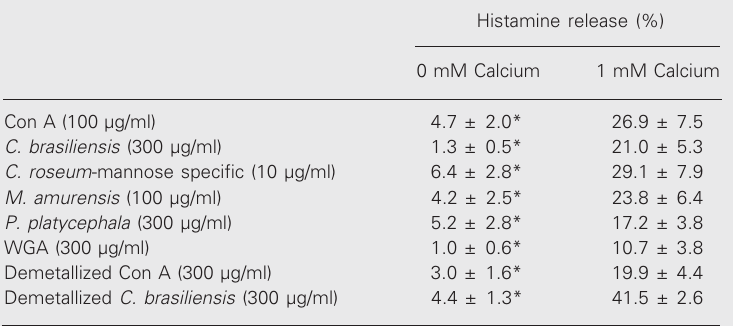
Figure 2. Histamine release in- duced by glucose-saturated lec- tins from Wistar rat peritoneal mast cells. Data are reported as means and SEM for 6 experi- ments. Con A = concanavalin A; C. brasiliensis = Canavalia brasi- liensis . *P < 0.05 compared to non-saturated lectin (Student t - test for paired samples).